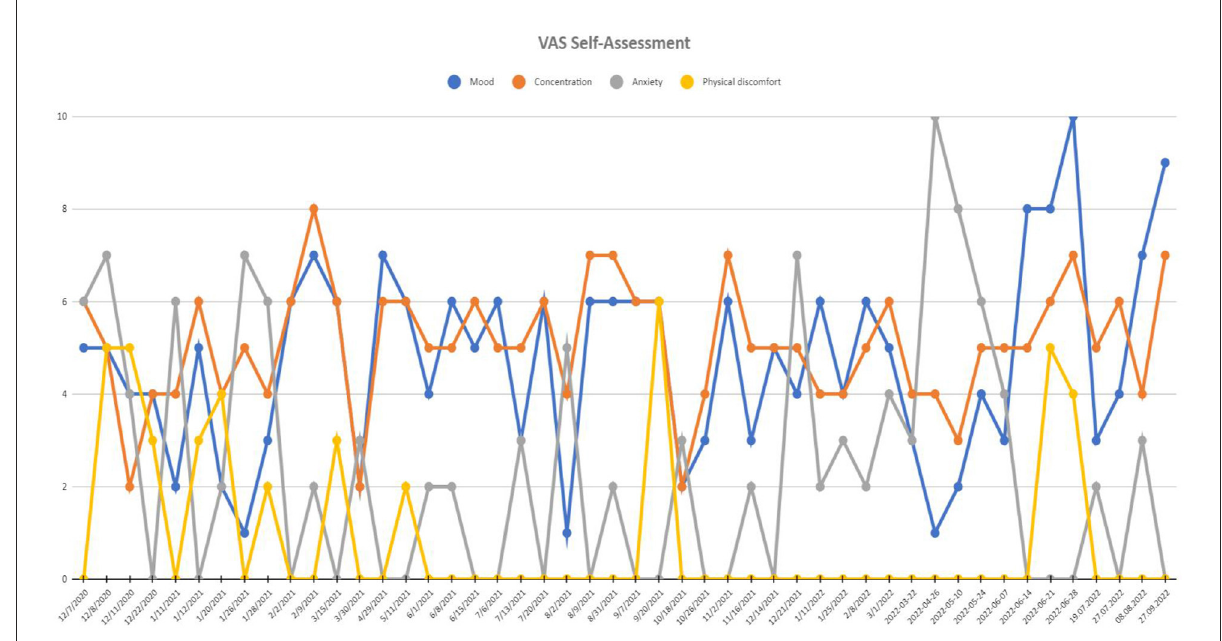
FIGURE4 Visual analog scale (VAS) of self-assessment scores at recruitment point and during 20 months of active DBS stimulation period. Mood and concentration scales were scored positively (0-worst mood and concentration and 10-best mood and concentration), while anxiety and physical discomfort scales were scored negatively (0-least intensive anxiety and discomfort and 10-most intensive anxiety and